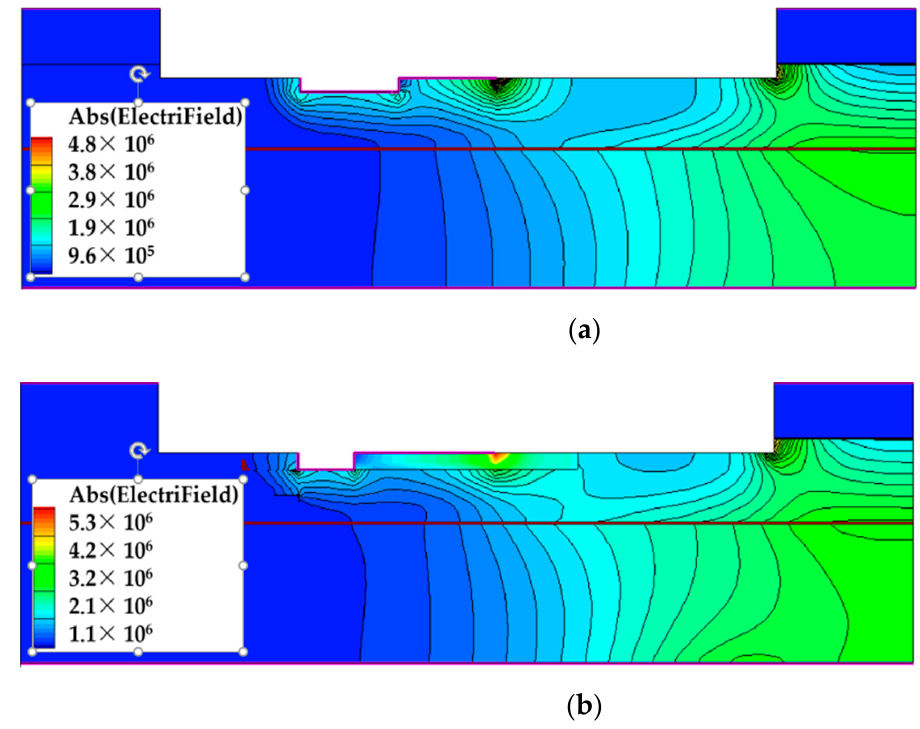
Figure 5. Potential distribution of the ( a ) DR structure and ( b ) proposed structure.